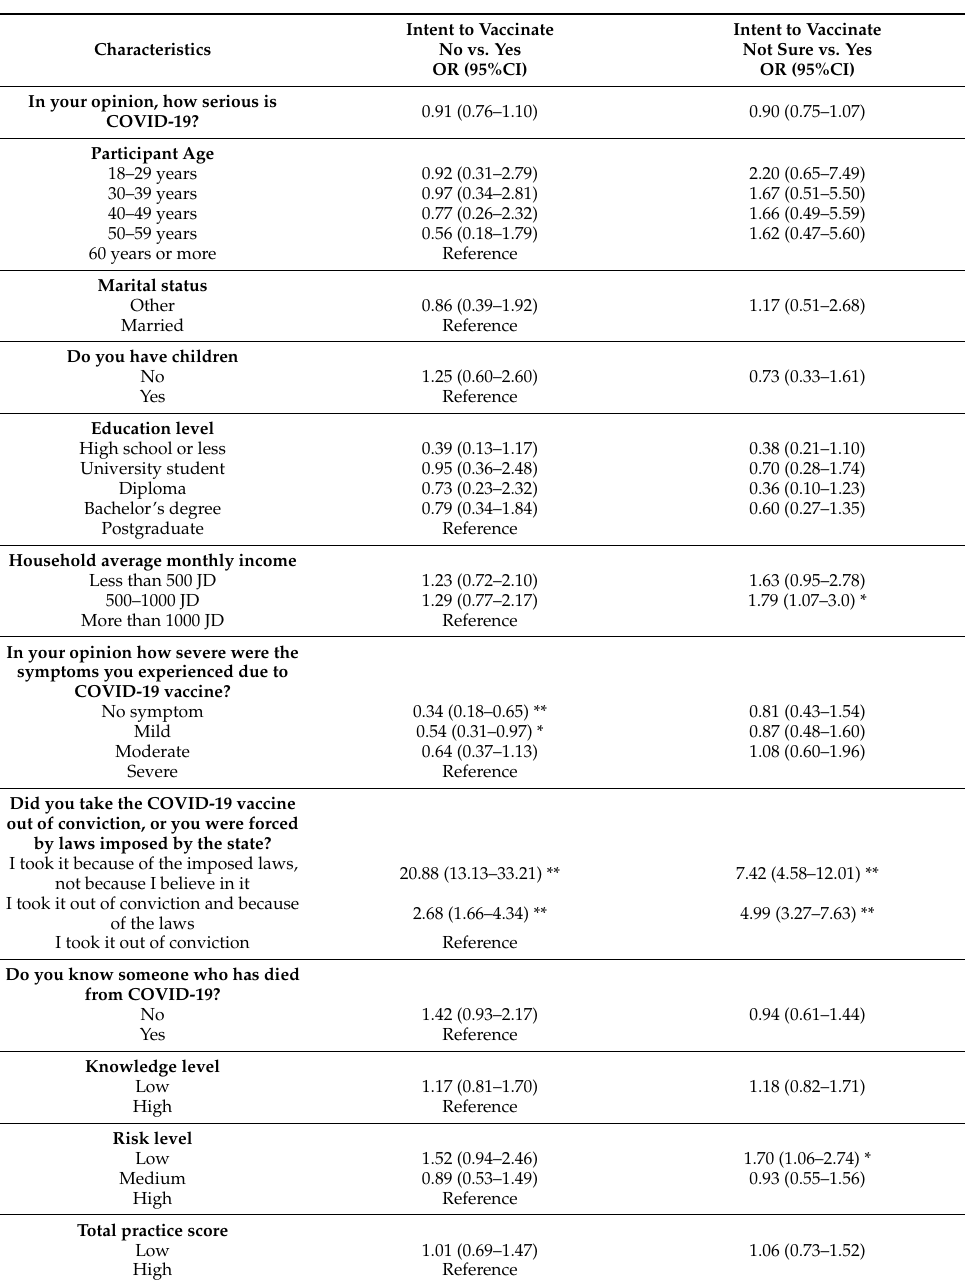
Table 3. Multivariate predictors of responding “not sure” or “no” regarding intent to get the booster dose of the COVID-19